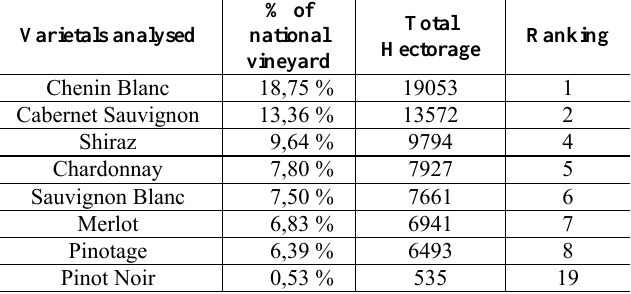
Table 3: Varietals analysed for brand-cue effects. Note: white and red blends are also included in the study.